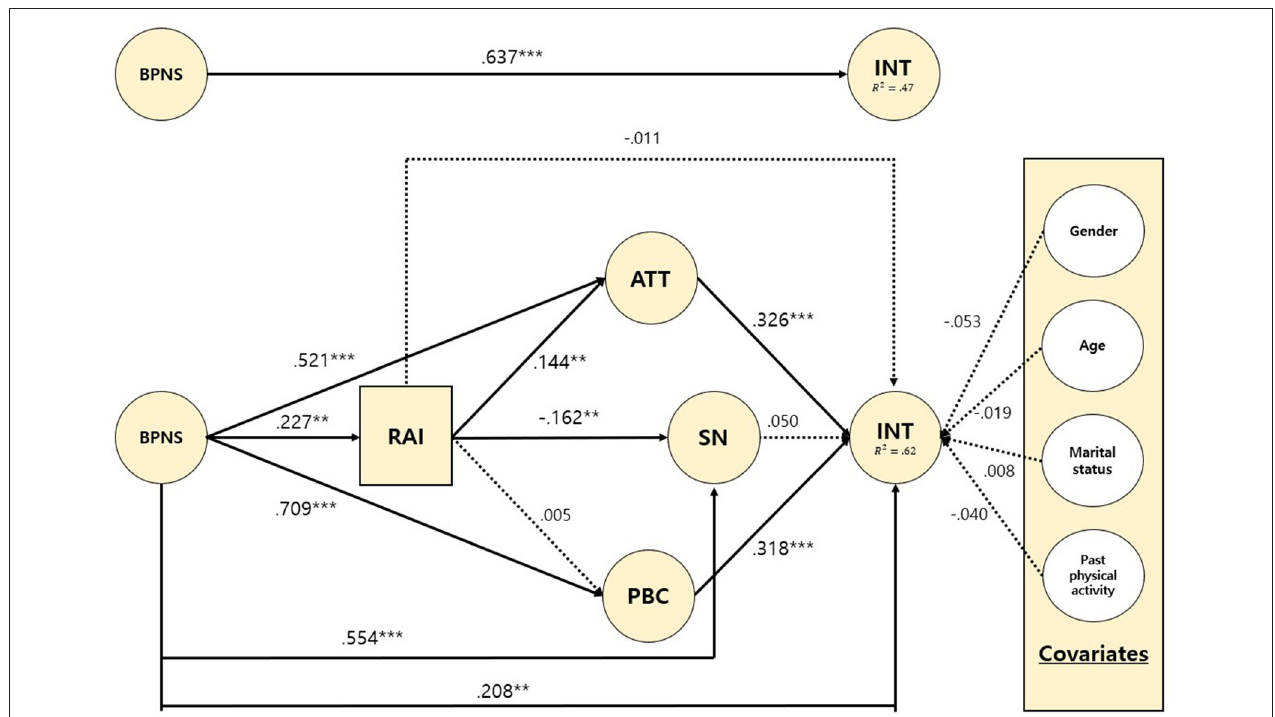
FIGURE 2 | Direct and mediation model with path coefficients. Note 1. The construct labels are as follows: BPNS, basic psychological needs satisfaction; RAI, relative autonomy index; ATT, attitudes; SN, subjective norms; PBC, perceived behavioral control; INT, intention. Note 2. The covariate codes are as follows: Gender = male (1), female (2); Age (yrs) = continuous (19 ∼ 60); Marital status = Single (1), With family/partner (2); Past physical activity (min.) = continuous (0 ∼ 1260). Note 3. All statistics represent direct relationship between variables. ** p < 0.01, *** p <